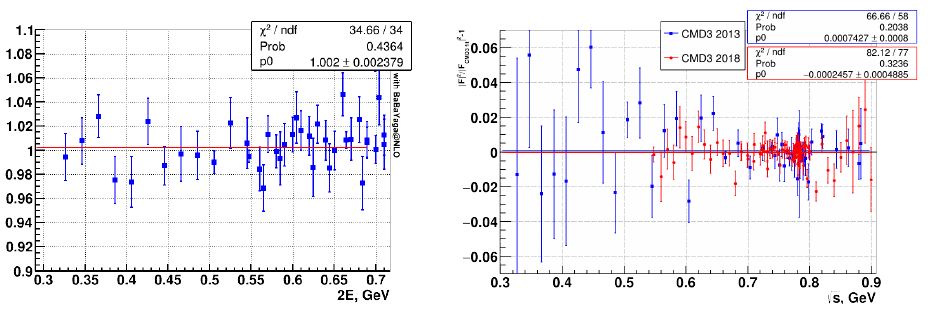
Figure 5. Preliminary results of the measurement of muon pair production in comparison with the QED prediction